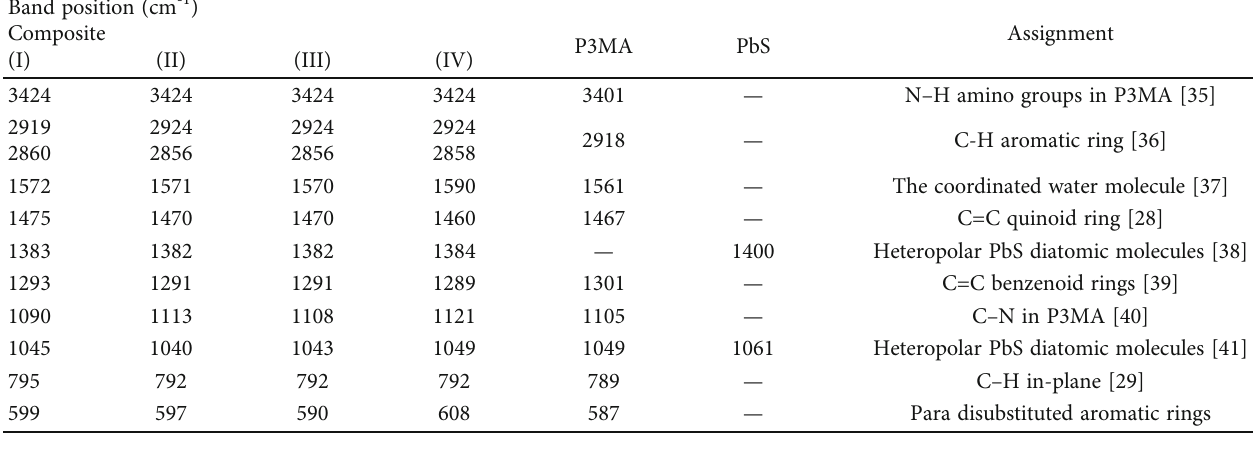
Table 1: A summary of the FTIR band positions for P3MA, PbS, and P3MA/PbS.